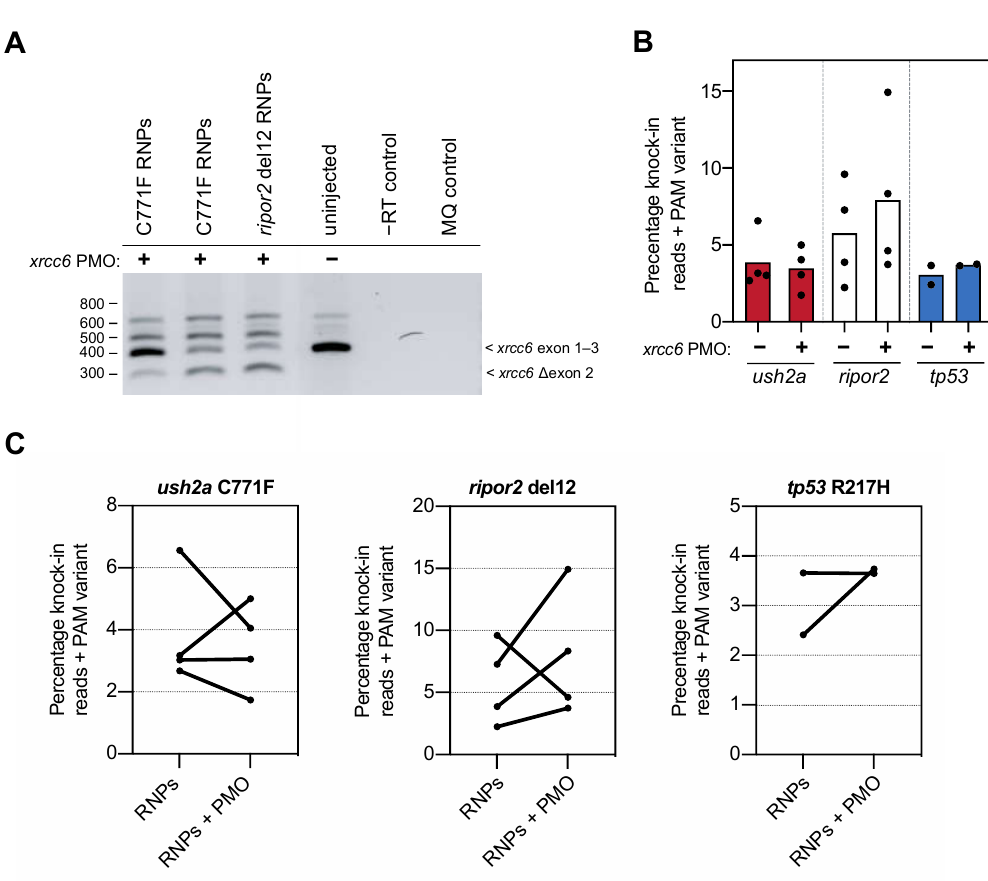
Figure 3. Knock-in efficiency after co-delivery of the xrcc6 -targeting PMO. ( A ) Addition of the xrcc6 -targeting PMO to the RNP injection mixtures results in alterative xrcc6 splicing. Both intron retention and exon 2-skipping are observed upon RT-PCR analysis of the xrcc6 transcript in PMO-injected embryos, but not control injected embryos. Replicate injections of C711F RNPs provide insight in variability of PMO-induced alterative xrcc6 splicing. ( B ) Quantification of knock-in efficiency after sgRNA-Cas9 RNP and template injection with and without co-injection of the xrcc6 -targeting PMO. For ripor2 , possibly tp53, but not ush2a , an increase in knock-in events is observed after co-injection of sgRNA-Cas9 RNPs, template oligonucleotide and the xrcc6 -targeting PMO. Results are expressed as mean (bars) and individual replicates (scatterplot). Only reads that include the PAM variant are included in the quantification to ensure that all quantified correct knock-in reads are the project of homology directed repair. ( C ) Comparison of changes in knock-in efficiency between embryos of the same clutch of eggs. For ush2a C771F RNPs, addition of the PMO to the injection mixture leads to variable outcomes in knock-in efficiency between the replicate injections. Three out of the four replicate injections of ripor2 del12 RNPs with xrcc6 -tarageting PMO display a higher knock-in efficiency, while for tp53 the addition of the PMO leads to an increase in knock-in efficiency in one of the two replicate injections.